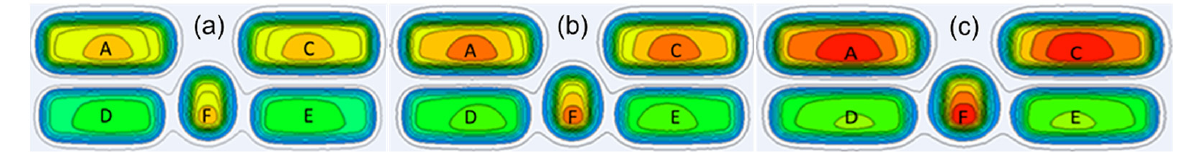
Figure 9. Funnel mold electromagnetic field cloud map. ( a ) 300-200, ( b ) 800-600 and ( c ) 1100-800 A.